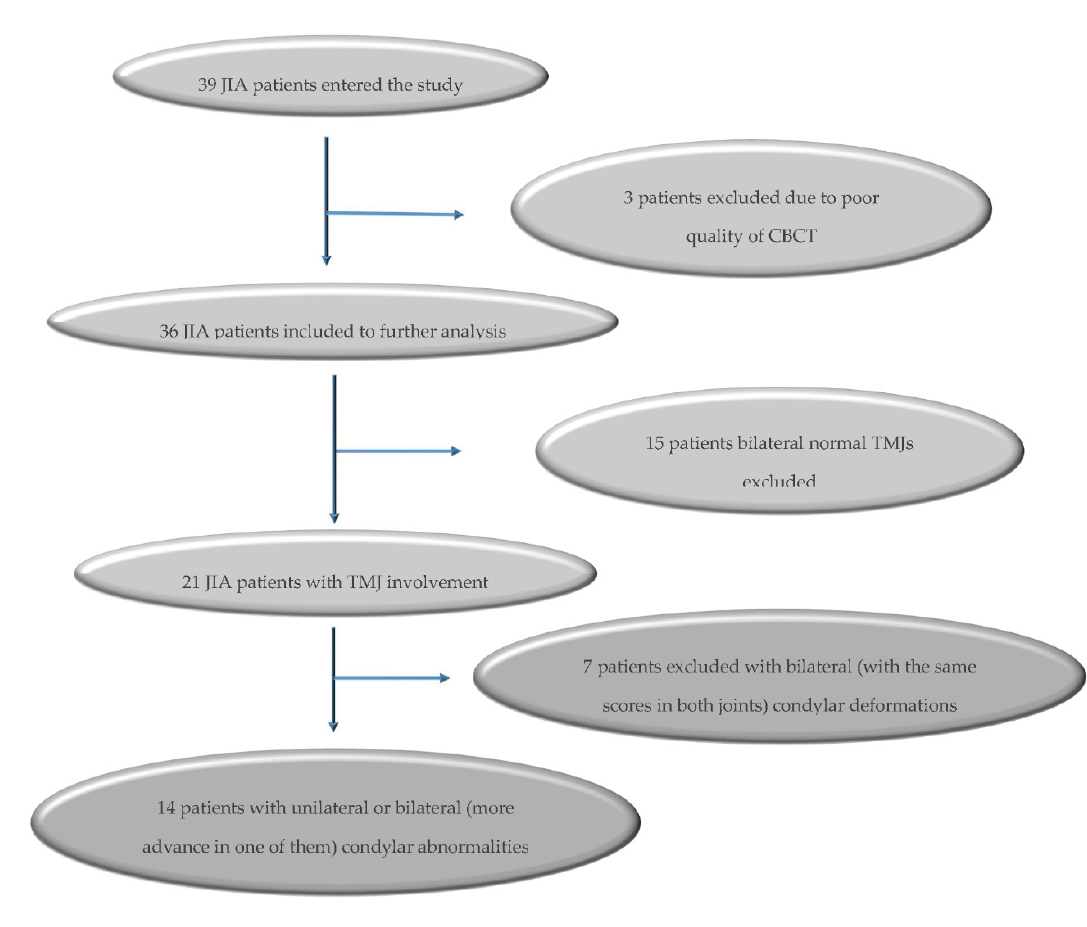
Figure 2. Flow chart of included juvenile idiopathic arthritis (JIA) patients. Table 1. Anatomical landmarks of face and oral cavity used in the